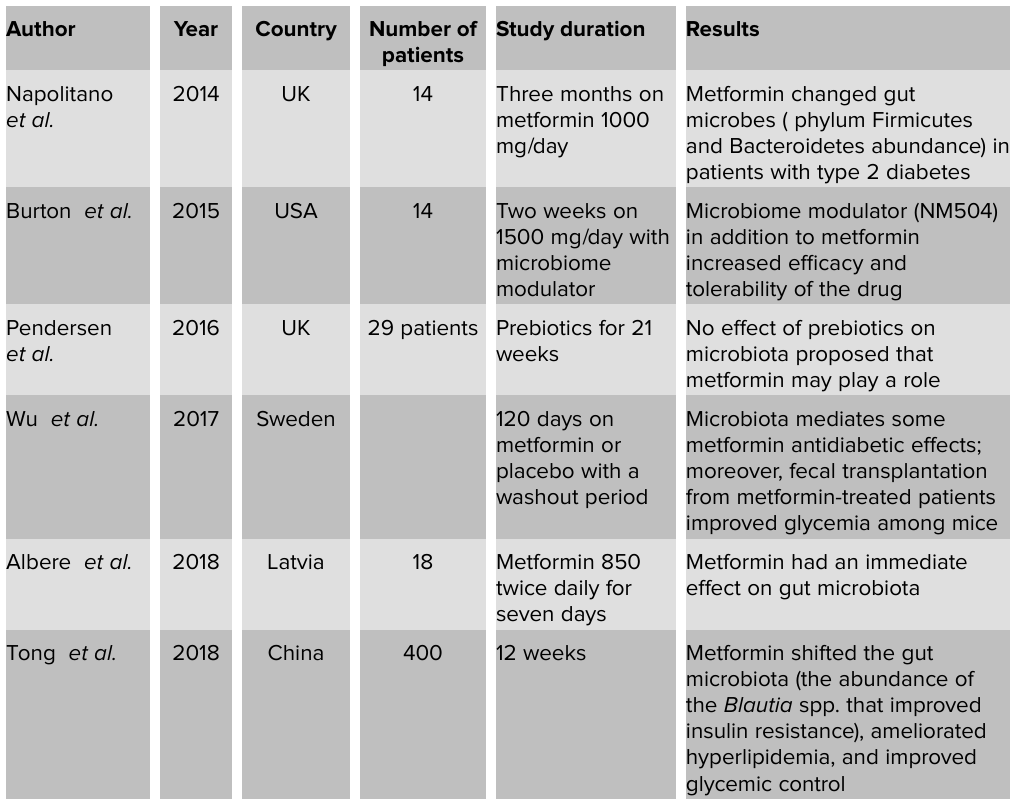
TABLE 1: The relationship between metformin and gut